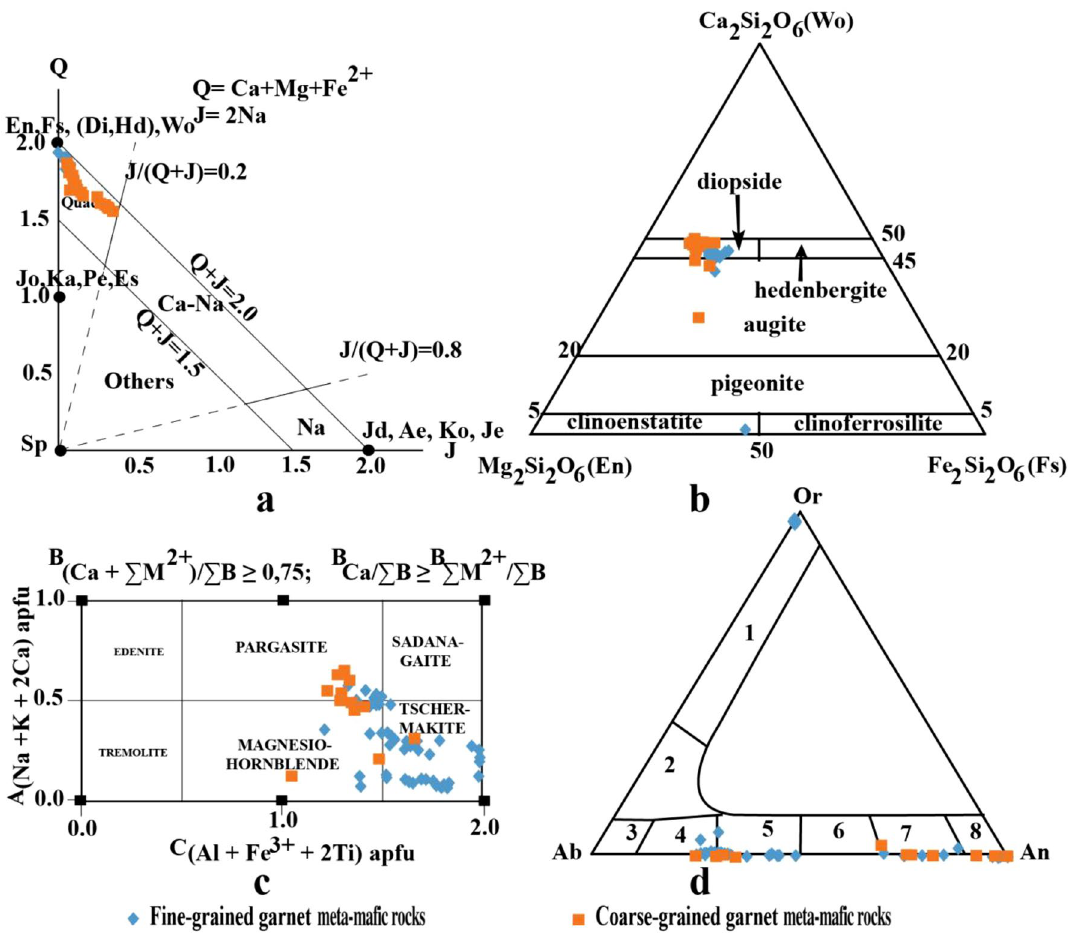
Fig. 5 a Q-J diagram showing studied sample plotting within the quad field, b Ternary diagram (En-Wo-Fs) for pyroxene classification [55], c Amphibole classification of studied samples [54], d Ab-Or-An ternary diagram of plagioclase